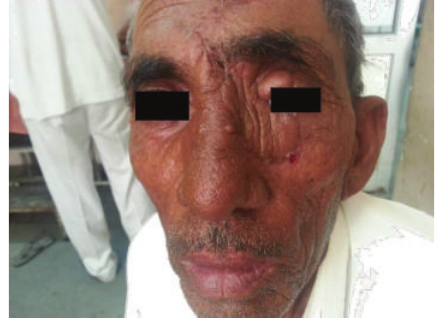
Figure 5: Final result at